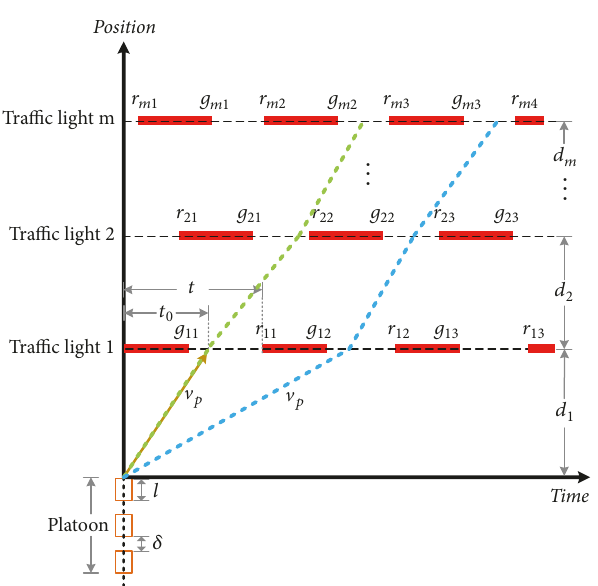
Figure 2: Schematic of the trajectory and velocity of leader vehicle.